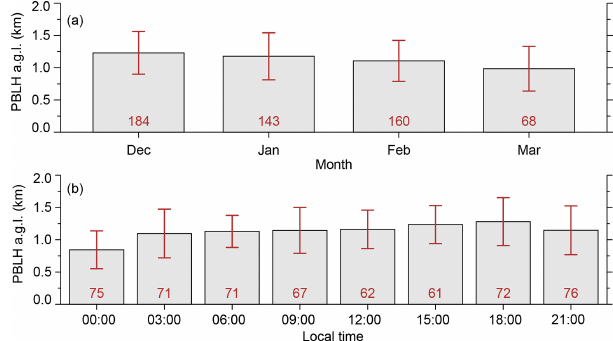
Figure 12. Height of the PBL determined by Polly XT between 4 December 2009 and 31 March 2010. (a) Monthly averaged PBL top heights including the standard deviation as error bars and (b) av- eraged PBL top height as function of time of day (averaged over 3h) including standard deviation as error bars. The red numbers in- dicate the number of measurements of the according bar. Local time is UTC −